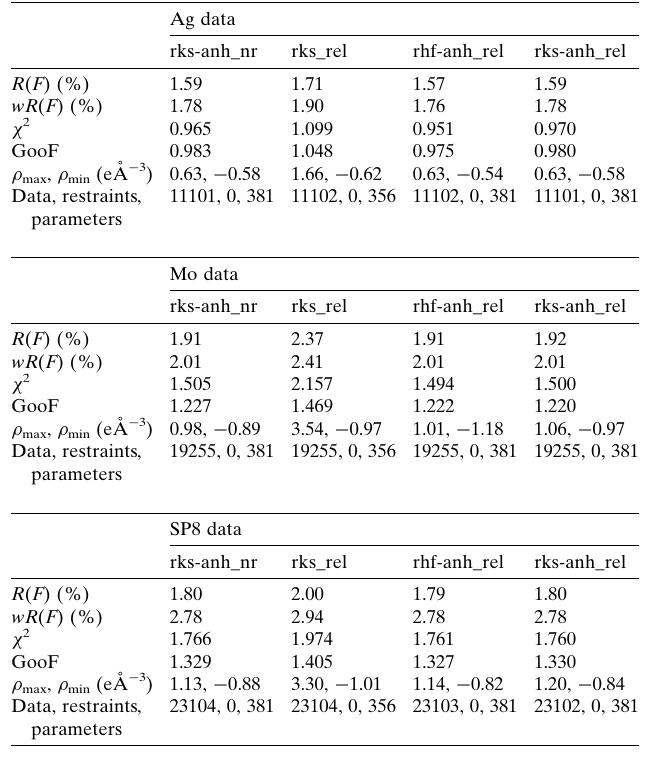
Table 3 Statistical parameters of all HARs considered for the Ag, Mo and synchrotron